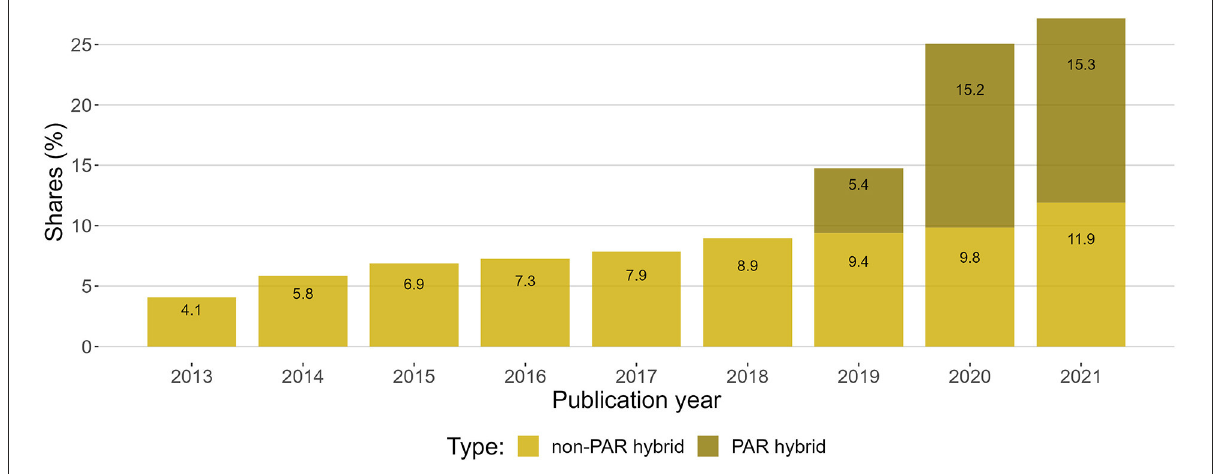
FIGURE5 Shares of PAR hybrid and non-PAR hybrid open access articles of total output of articles in the period 2013–2021.